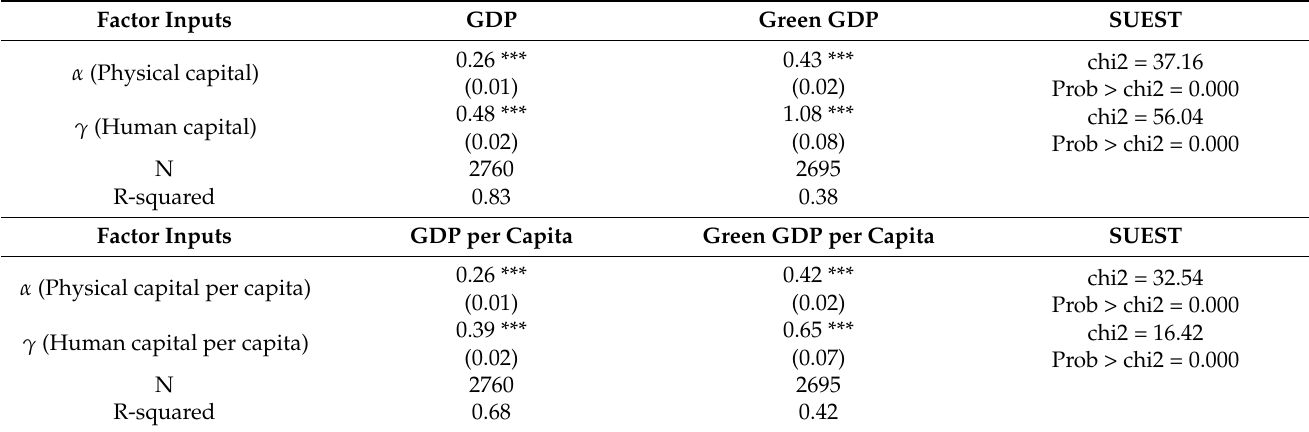
Table 5. OLS regressions of GDP and green GDP on physical capital and human